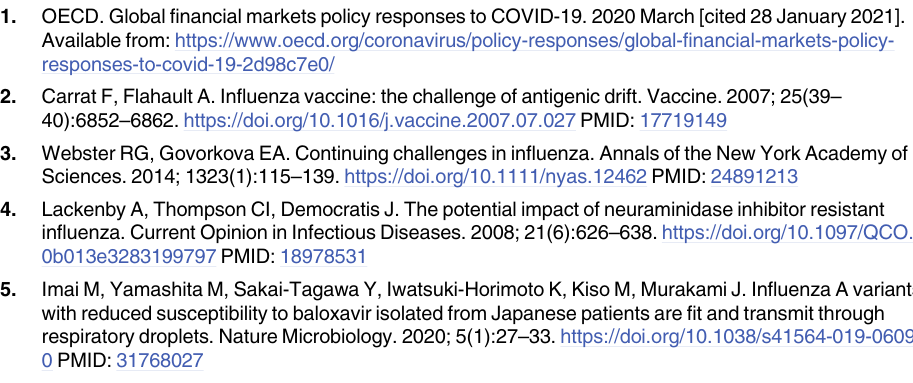
S4 Table. Sensitivity of intracellular and cell population model parameters. S5 Table. Primers used for real-time RT qPCR of mRNA. S6 Table. Primers used for reference standard generation of